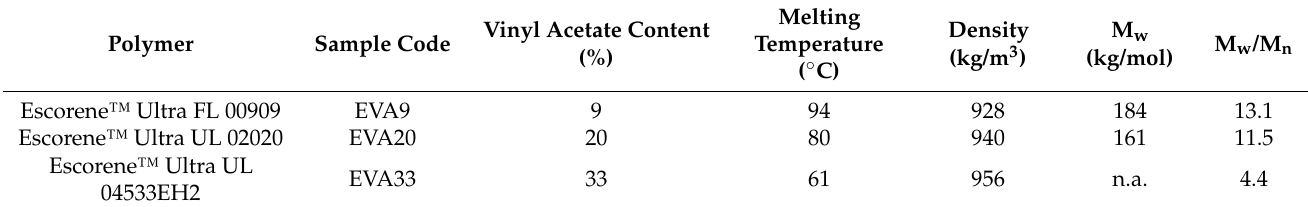
Table 1. Main characteristics of the EVAs used in this